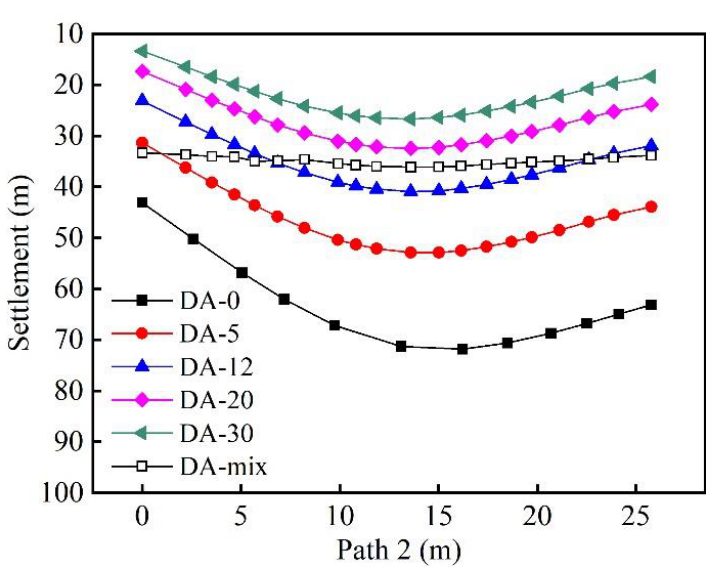
Figure 9. Curve of raft settlement along path 2 .